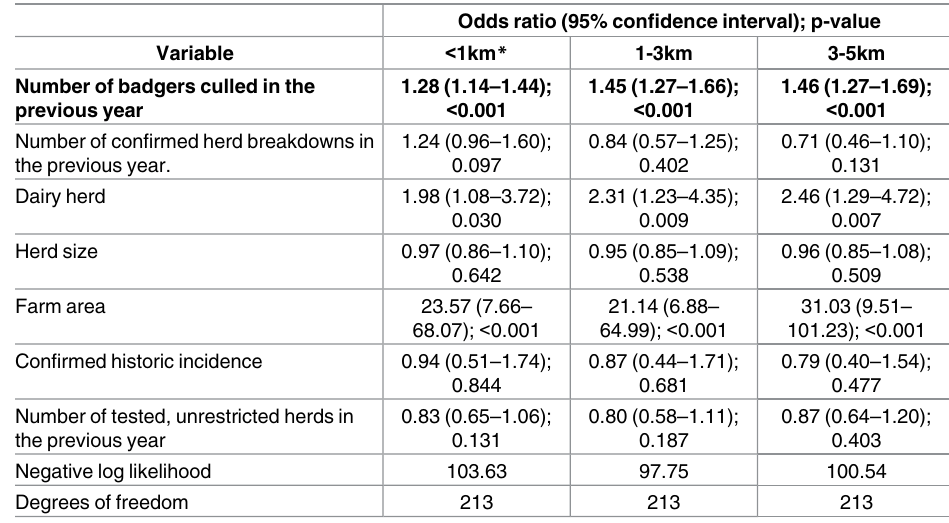
Table 2. Results of models including only a single circle or annulus with the aim of investigating associations between herd-breakdowns and the number of badgers culled within the RBCT within the previous year, while adjusting for confirmed herd breakdowns and other herd-levels covariates. Results are presented of analysesbased on data quantified,where appropriate, within a 1km radius, a 1-3km annulus,and a 3-5km annulusof the case-control. Estimated odds ratios and their confidence intervals corre- spond to the change in risk of herd breakdown associated with a doubling of that